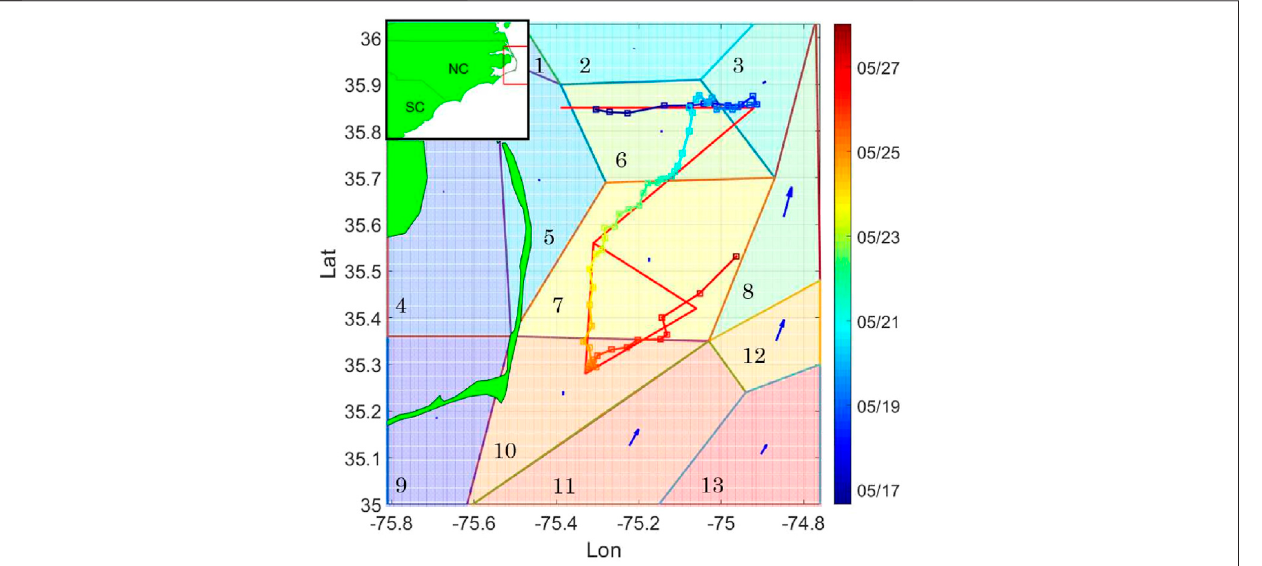
FIGURE 5 | Partitioned cells of the survey domain. The polygons are the partitioned regions. The blue arrows represent uniform fl ow speed in each of the cells generated from the proposed algorithm.